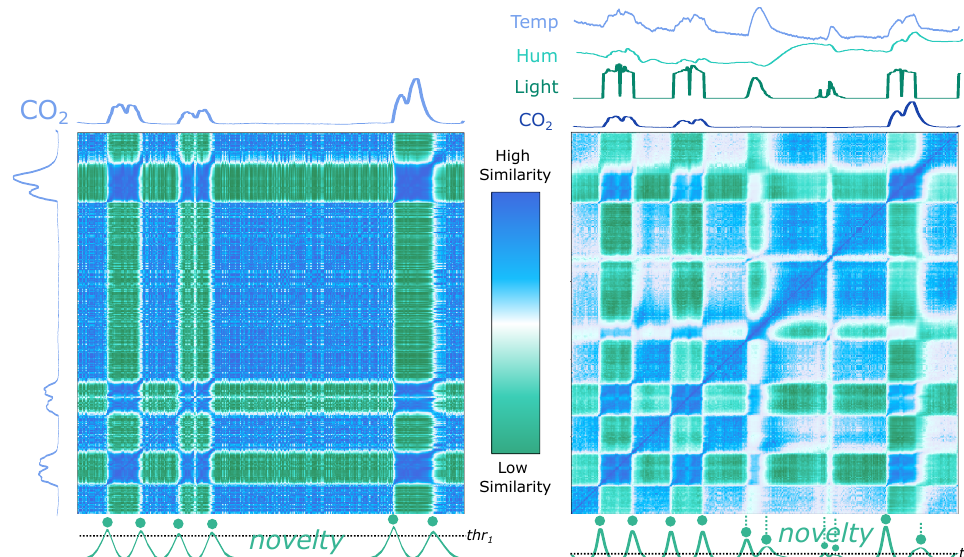
Figure 9. The proposed method was applied to the Occupancy record of Dataset 5 (CPDBenchmark, see Section 3.5). ( Left ): calculations on the separate CO 2 time series only; ( right ): calculations performed by extracting features on the complete four time series. The novelty function is presented and peaks are aligned with ground truth events, represented as the dashed line and